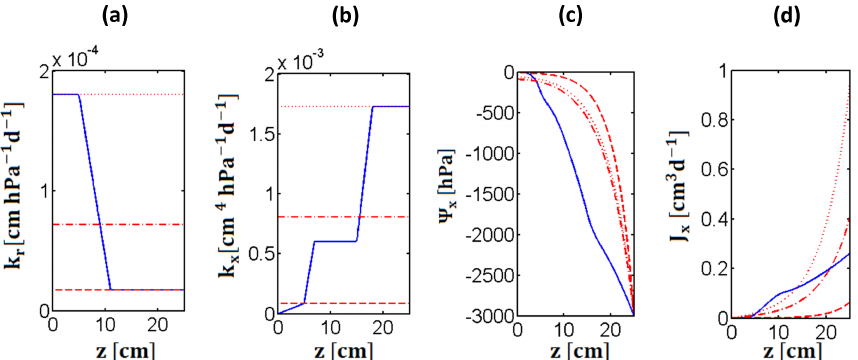
Figure 7. Distributions of radial conductivity (a) , axial conductance (b) , xylem water potential (c) and axial water flow (d) in a maize lateral root. We used hydraulic properties obtained by Doussan et al. (1998b) (blue solid line) for a maize lateral root or equivalent properties (red lines) with minimal (dashed), maximal (dotted) or mean (dashed-dotted) values. The origin of the z-axis is at the root